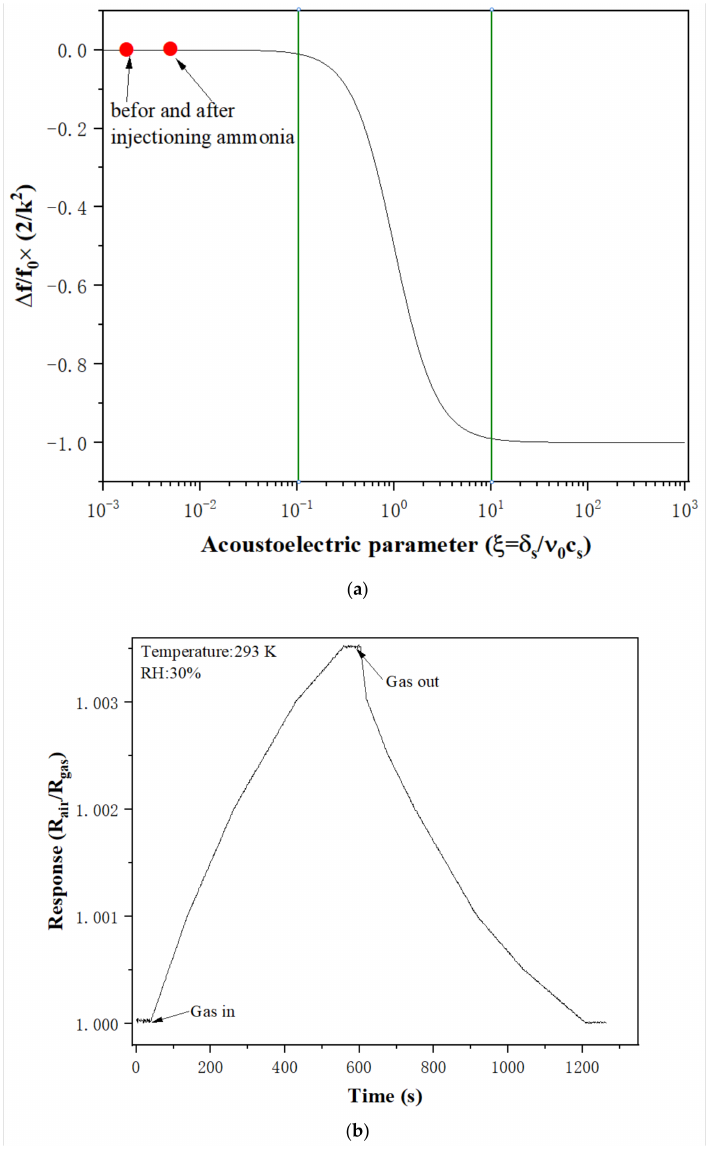
Figure 8. ( a ) Frequency changes of the PAA film SAW sensor versus acoustoelectric parameter ξ ; ( b ) Resistance changes of PAA film before and after exposure to 20 ppm